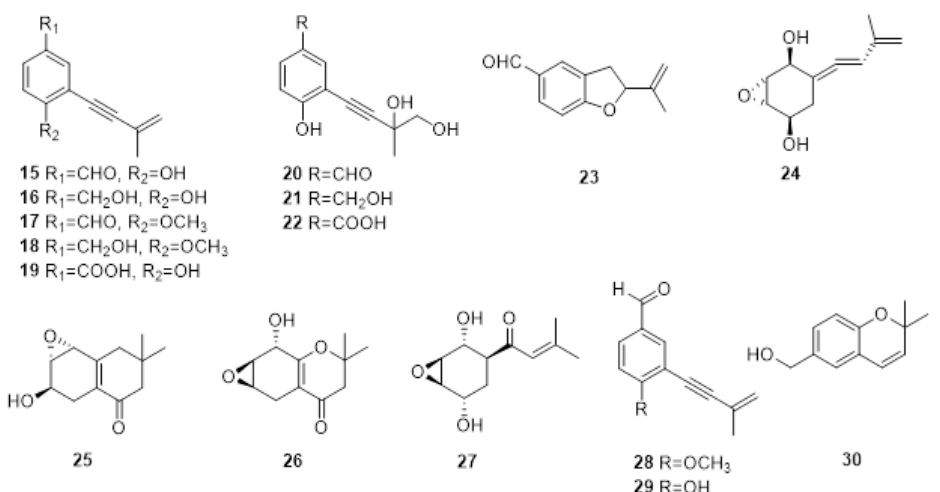
Figure 3. Structure of scytalone eutypine ( 15 ), eutypinol ( 16 ), O-methyleutypine ( 17 ), O-meth- yleutypinol ( 18 ), eutypune carboxylic acid ( 19 ), 4-ydroxy-3,4-dihydroxy-3-methylbut-l-ynyl)benzyl alcohol ( 20 ), 4-hydroxy-3-(3,4-dihydroxy-3-methylbut-l-ynyl)benzaldehyde (21), 3-hydroxy-3,4- diliydroxy-3-methylbut-I-ynyl)benzoic acid ( 22 ), 5-formyl-2-(methylvinyl)[1]benzofuran ( 23 ), 5-(3- methylbuta-l.3-dienylidene)-2,3-epoxycyclohexane-l,4-diol ( 24 ), 6-hydroxy-2,2-dimethyl-5,6.7,8-tet- rahydro-7,8-epoxychroman ( 25 ) and 8-hydroxy-2,2-dimethyl-5.6,7,8-tetrahydro-6.7-epoxychroman ( 26 ), eutypoxide B ( 27 ), eulatinol ( 28 ), siccayne ( 29 ), eulatachromene ( 30